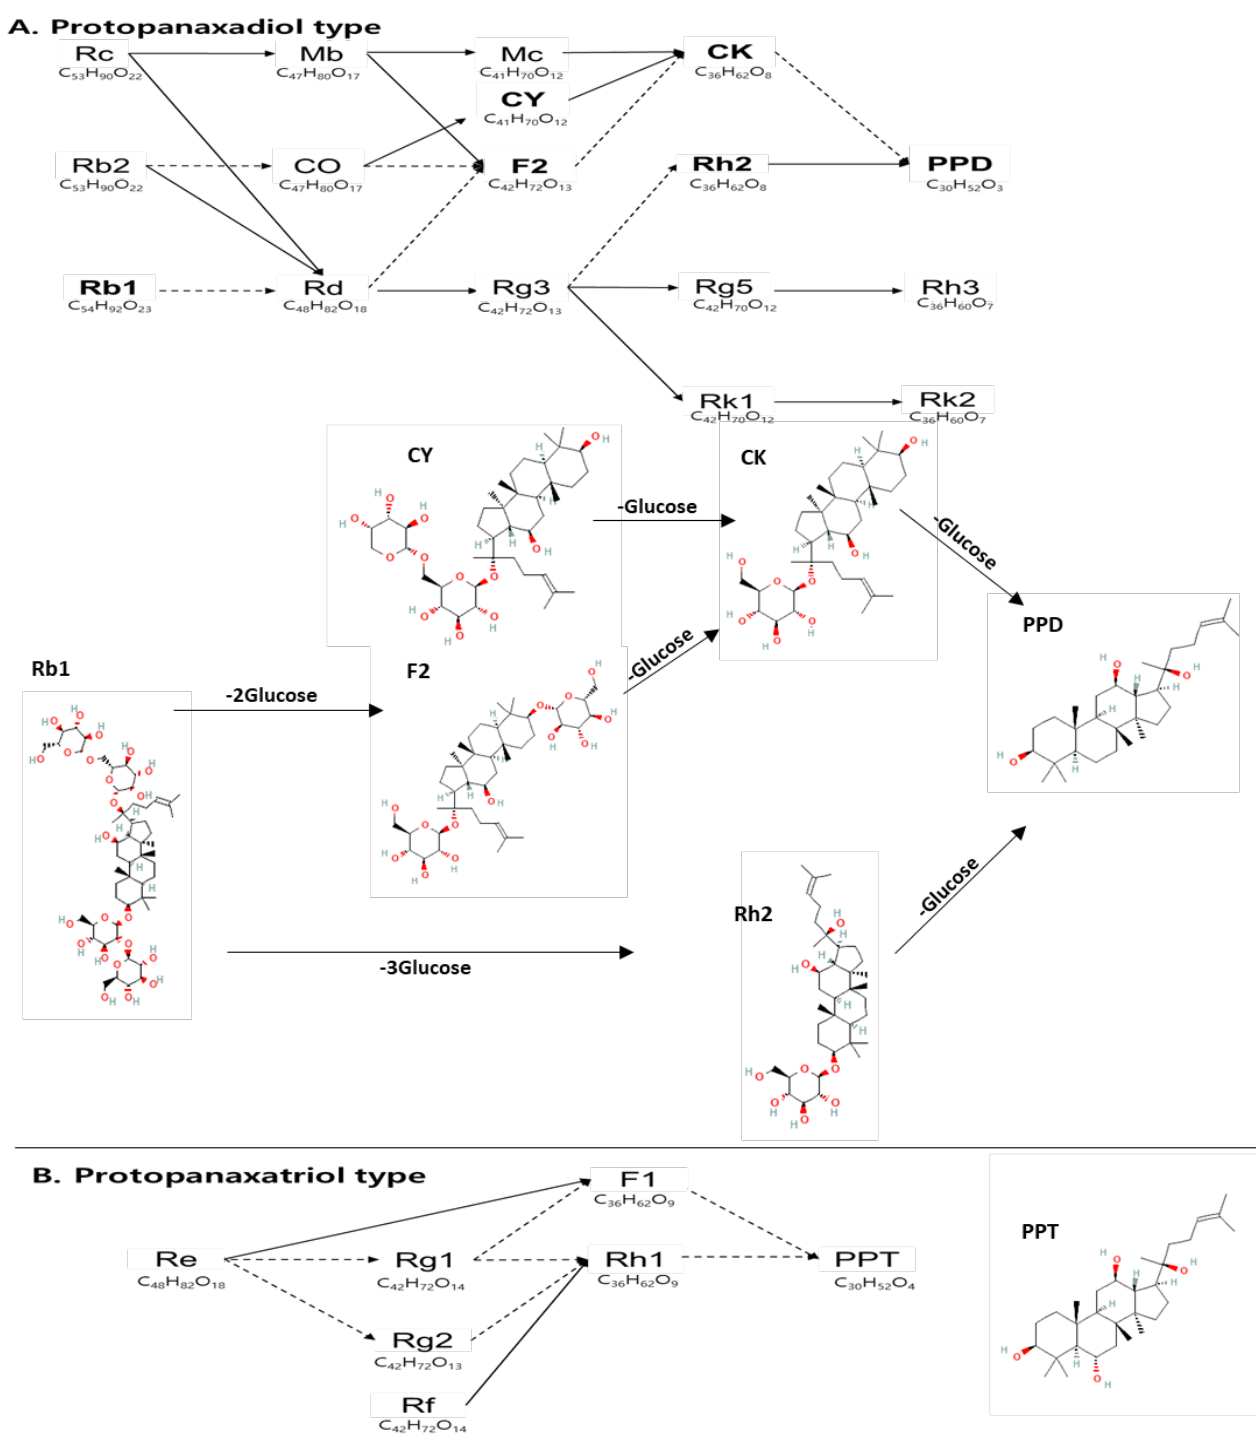
Figure 1. Metabolic pathway of ginsenosides. Ginsenosides are composed of protopanaxadiol (PPD) and protopanaxatriol (PPT) types. Rc, Rb2, Rb1, Mb, CO, Rd, Mc, CY, F2, Rg3, CK, Rh2, Rg5, Rk1, PPD, Rh3, and Rk2 are assigned to the PPD type, and Re, Rg1, Rg2, Rf, F1, Rh1, and PPT are assigned to the PPT type. Dashed lines indicate metabolic conversion by microflora in the human intestinal tract [https://www.koreascience.or.kr/article/JAKO200930858709274.pdf] accessed on 2 September 2022. All structures of analyzed ginsenosides are from PubChem